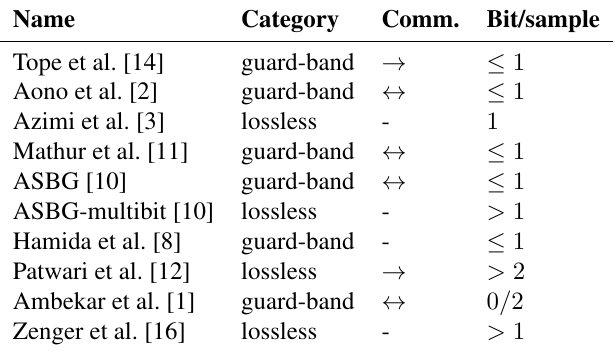
Table 1: Details of the covered quantization schemes.